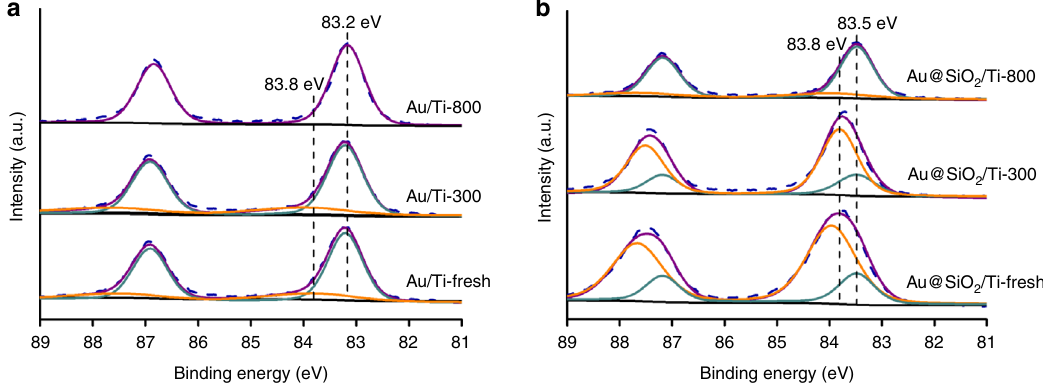
Fig. 4 Au 4 f XPS spectra of various catalysts. a Au/Ti-fresh, Au/Ti-300 and Au/Ti-800; b Au@SiO 2 /Ti-fresh, Au@SiO 2 /Ti-300, and Au@SiO